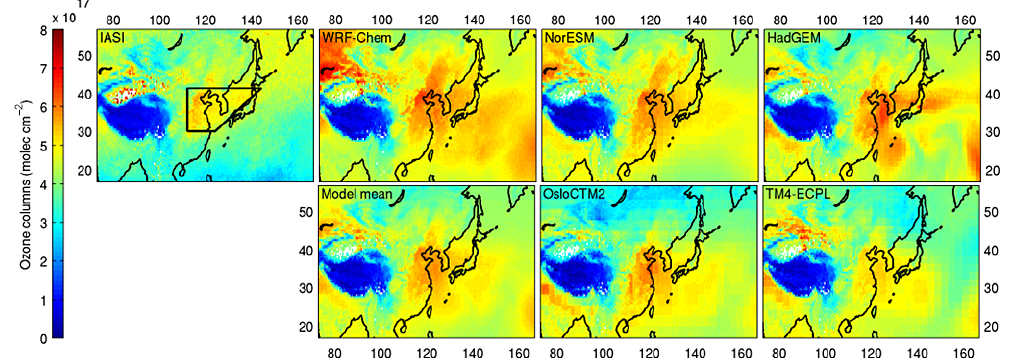
Figure 2. Average 0–6km ozone columns (moleccm − 2 ) over Asia in August 2008 observed by the IASI satellite (left panel) and simulated by the models as well as the model mean (models names are given in each relevant panel). The black polygon delimits the region discussed in detail in the